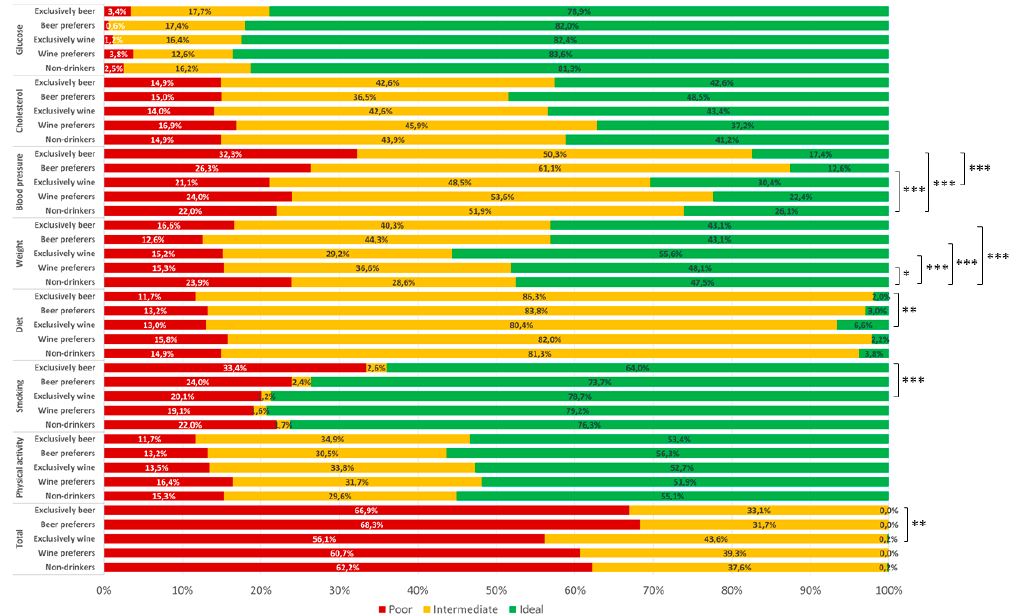
Figure 3. Distribution of cardiovascular health metrics according to beverage choices. * p < 0.05, ** p < 0.01, *** p < 0.001 based on the Chi-Squared test using non-drinkers as reference group.